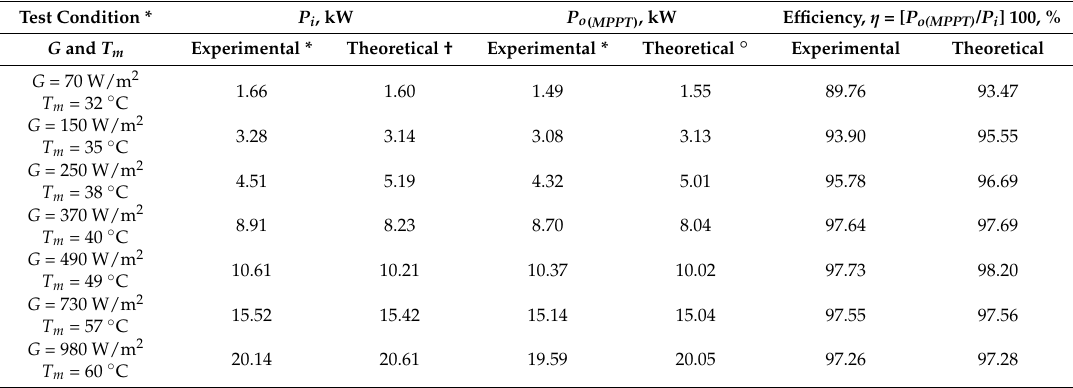
conditions. † Theoretical values of P i are calculated for the same test conditions by using the dynamic to theoretical values of P i .